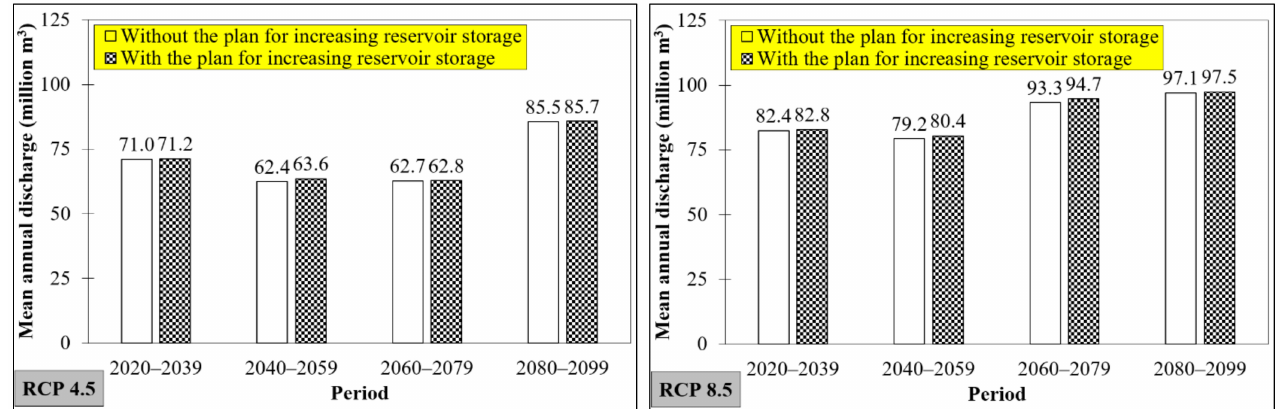
Figure 4. The comparison of mean annual discharge under scenarios with and without the water resources management and development plan, and both climate and land use changes.